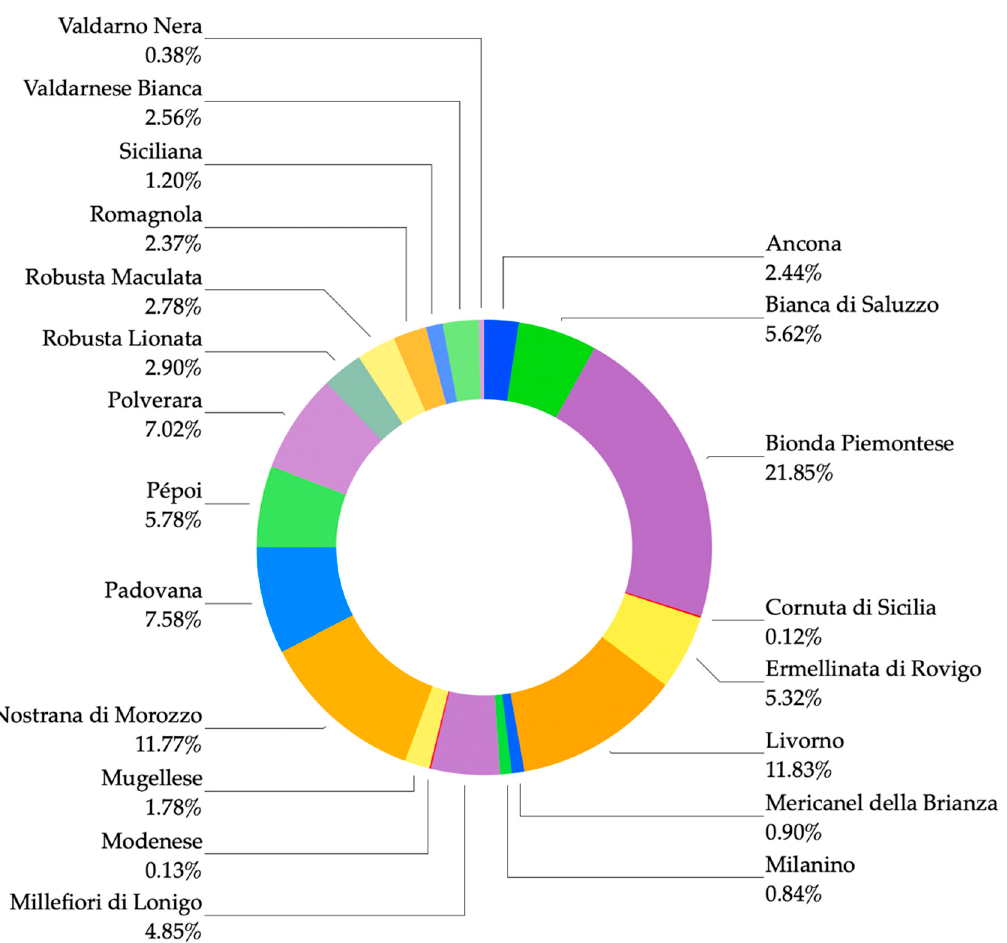
Figure 1. Native Italian poultry breeds recorded during the survey. Phenotypic information are available at: www.pollitaliani.it/en/ accessed on 27 February 2021 [28].